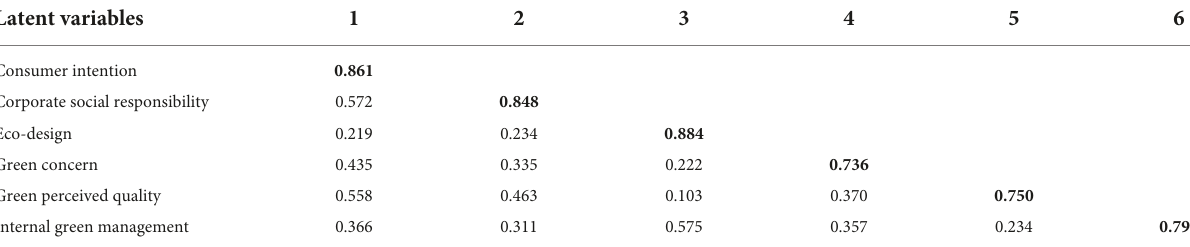
TABLE 4 Discriminant validity